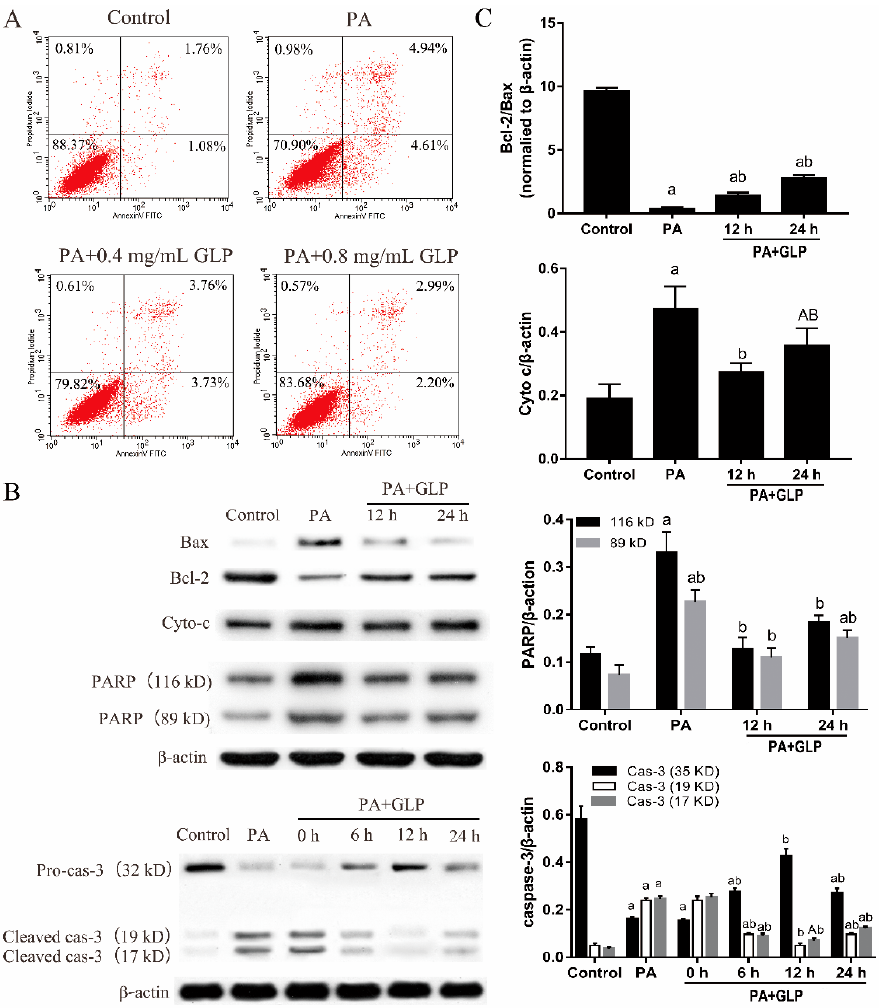
Figure 3. GLP prevented PA-induced apoptosis in IPEC-J2 cells. Cells were exposed to 0.4 and 0.8 mg/mL GLP in presence of 600 μ M PA for 24 h. ( A ) Quantification of IPEC-J2 apoptotic cells by flow cytometry. Four parts were observed: necrotic cells (upper left quadrants), late apoptotic and necrotic cells (upper right quadrants), viable cells (lower left quadrants), and early apoptotic cells (lower right quadrant). ( B ) The expressions of Bax, Bcl-2, Cyto c, caspase-3 (cas-3), and PARP were analyzed by Western blot. ( C ) The data were quantified and normalized to β -actin. Data shown are